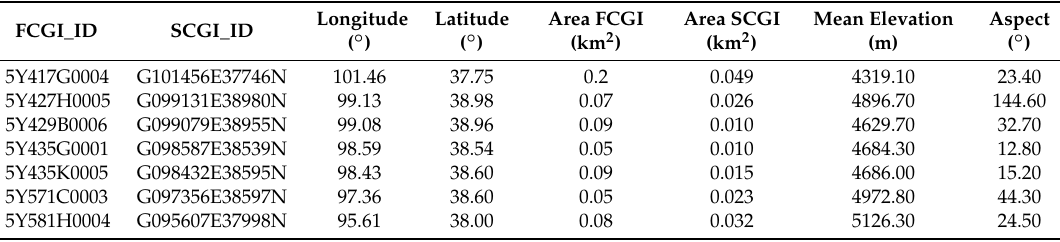
Table 3. Some attributes of disappeared glaciers from 2010 to 2015.